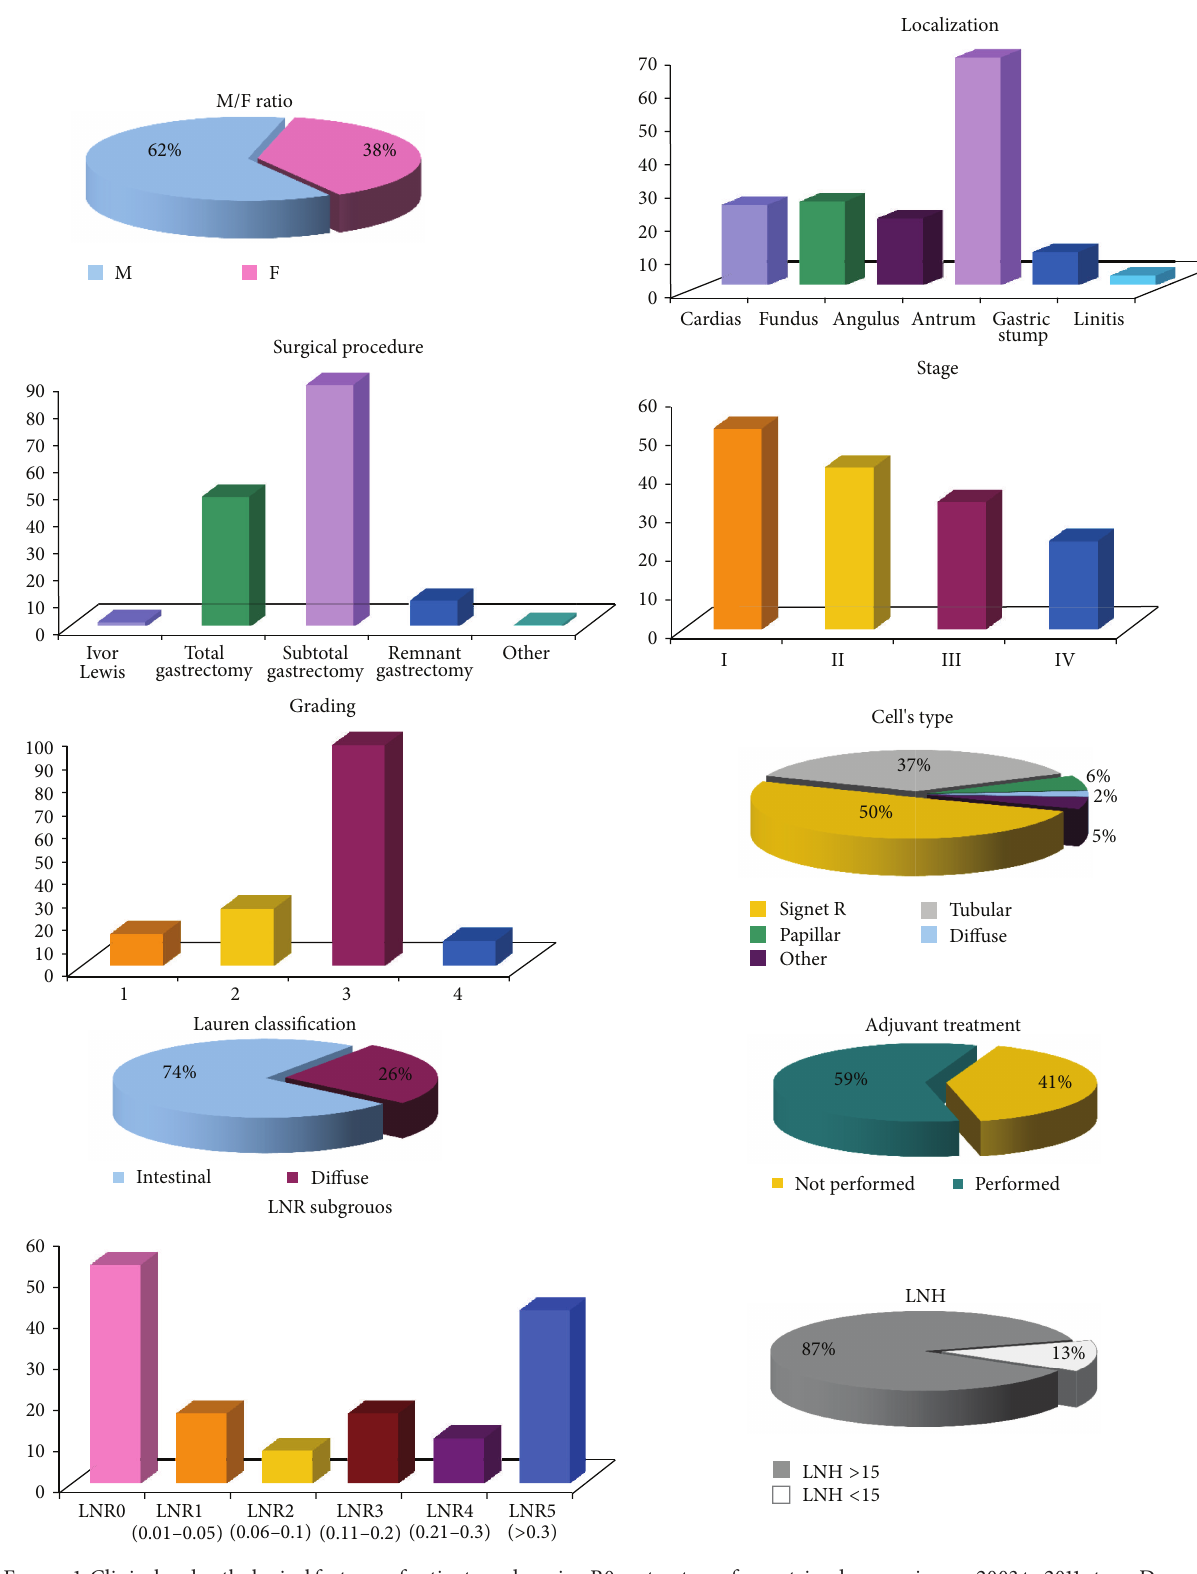
Figure1:ClinicalandpathologicalfeaturesofpatientsundergoingR0gastrectomyforgastricadenocarcinoma2003to2011atourDepartment including the M/F ratio, the localization of the tumors and the surgical treatments, the stage of the diseases, the grading of the tumors, the LNR and the LNH subgroups, the cellular types and Lauren classification, along with the rate of adjuvant treatment performed in our